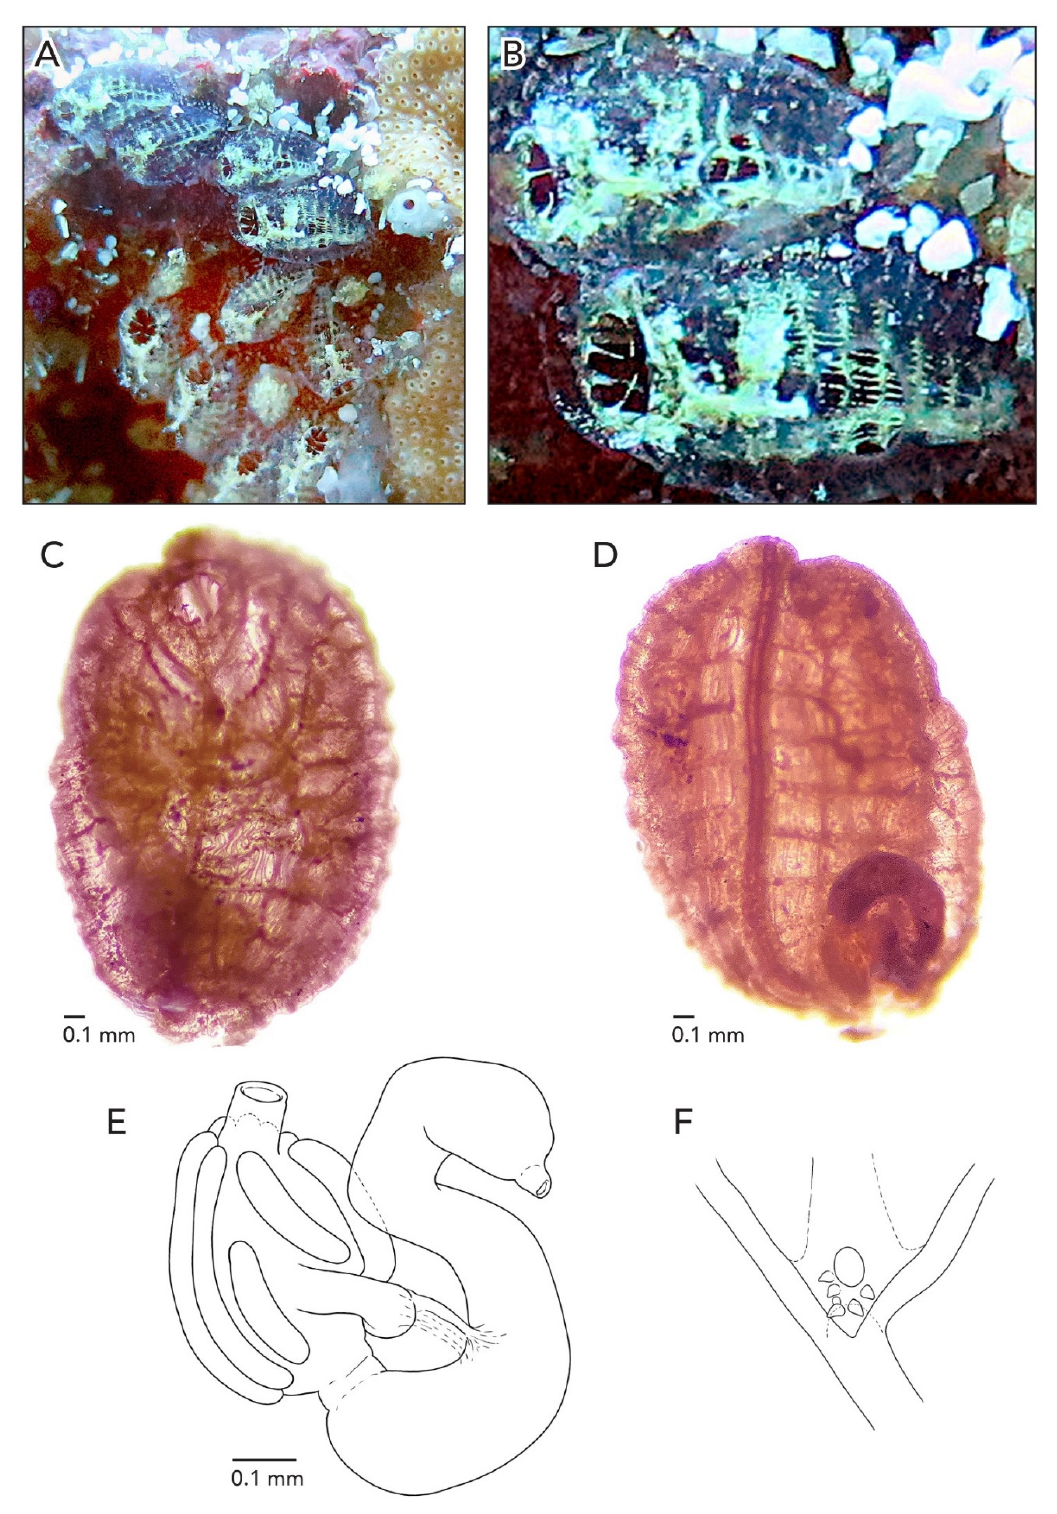
Symplegma papillata sp. nov. (Figure 2, Figure 14 and Figure 17) isodiametric as it twists away from the stomach. Testes and ovaries are not visible in this Holotype: CAGoM-2271, Bajos del Norte Reef (BN03), 15.7 m depth, 20 July 2019 col. colony. Lilian Palomino-Alvarez. Dead coral.